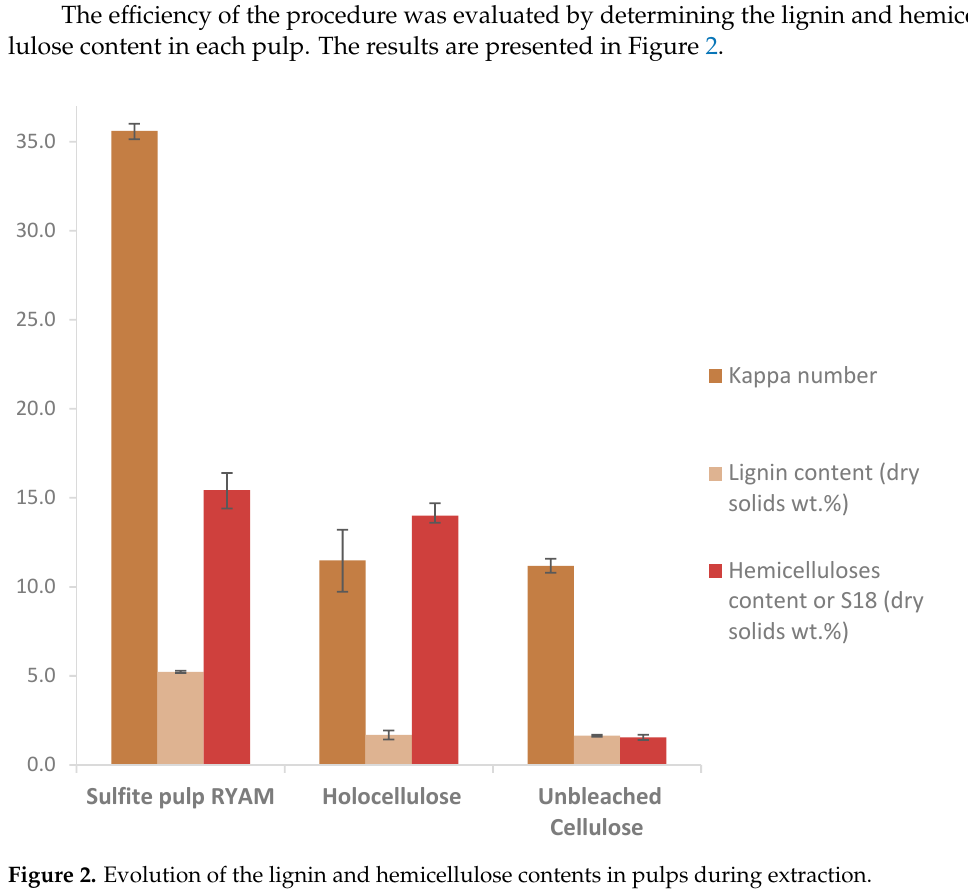
Table 2. Biopolymer composition of common softwood and sulfite pulps [2,10] compared to the RYAM sulfite pulp.